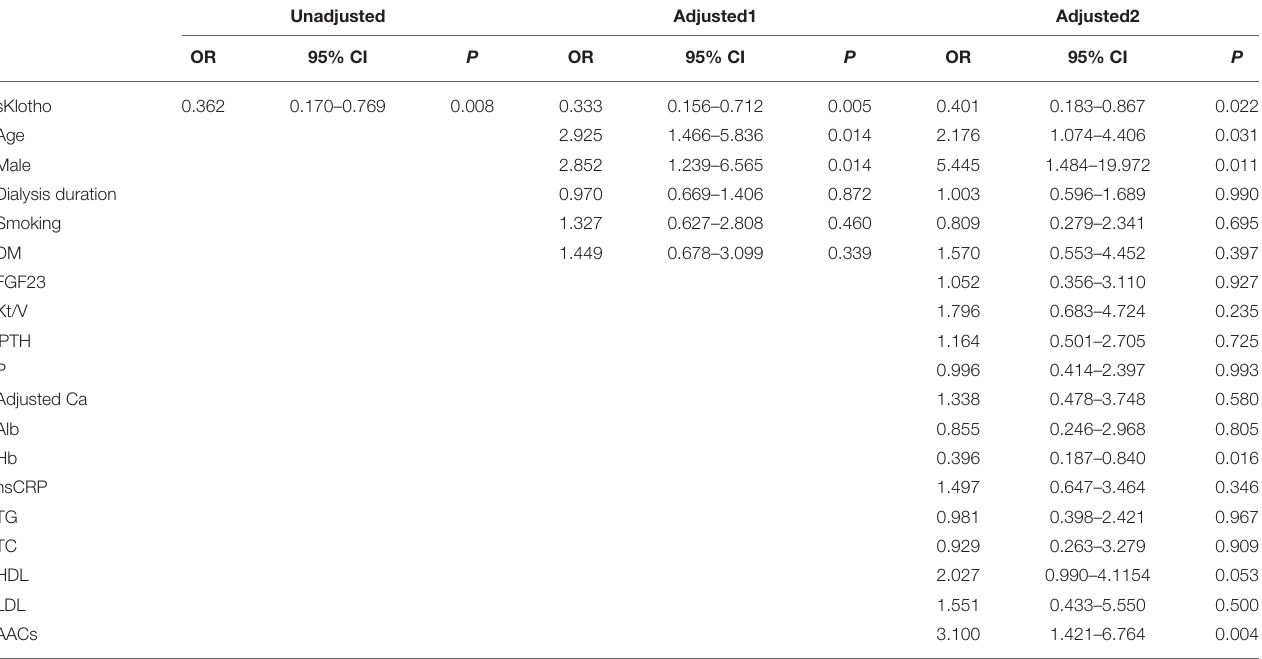
Statistical model used COX regression analysis for the risk of CVD death in MHD patients adjusting for demographic data and clinical data. Soluble Klotho level was associated with CVD death. This finding remained consistent in models that adjusted for age and sex, demographic data and clinical data (set sKlotho > 567.8 pg/mL = 1, sKlotho ≤ 567.8 pg/ml